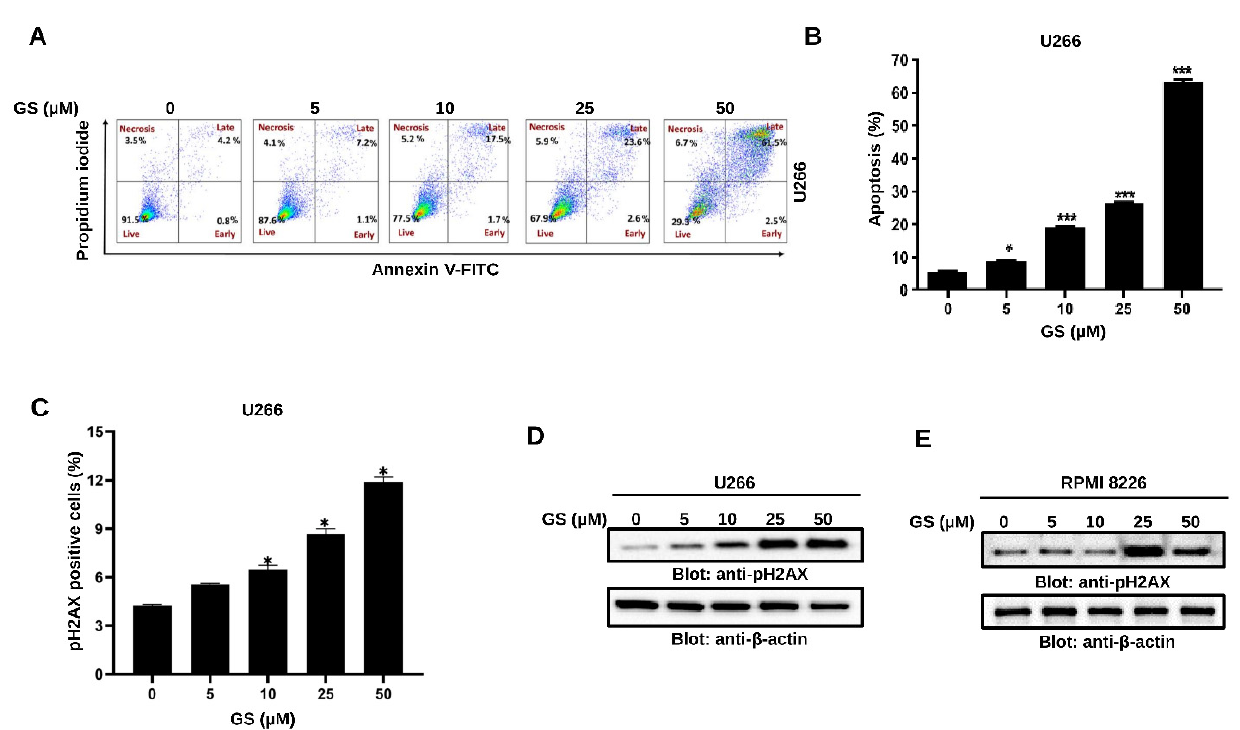
Figure 2. Apoptotic effects of GS on MM cells. ( A ) U266 cells were incubated with 5, 10, 25, and 50 µM of GS for 48 h. Representative graphs were obtained by flow cytometric analysis after double- staining with Annexin-V-FITC/PI. ( B ) The graph displays the values of mean ± SD of the percentage of the apoptotic cells of three independent experiments. * p < 0.05, *** p < 0.001. ( C ) U266 cells were incubated with 5, 10, 25, and 50 µM of GS for 48 h and analyzed for DNA double-stranded breaks using flow cytometry. The graph displays the mean ± SD of three independent experiments * p < 0.05. ( D ) U266 and ( E ) RPMI 8226 cells were treated with increasing concentrations of GS for 48 h, lysed, and immunoblotted against p-H2AX and β -actin. Full Western blot images can be found at Supplementary Materials File S1.